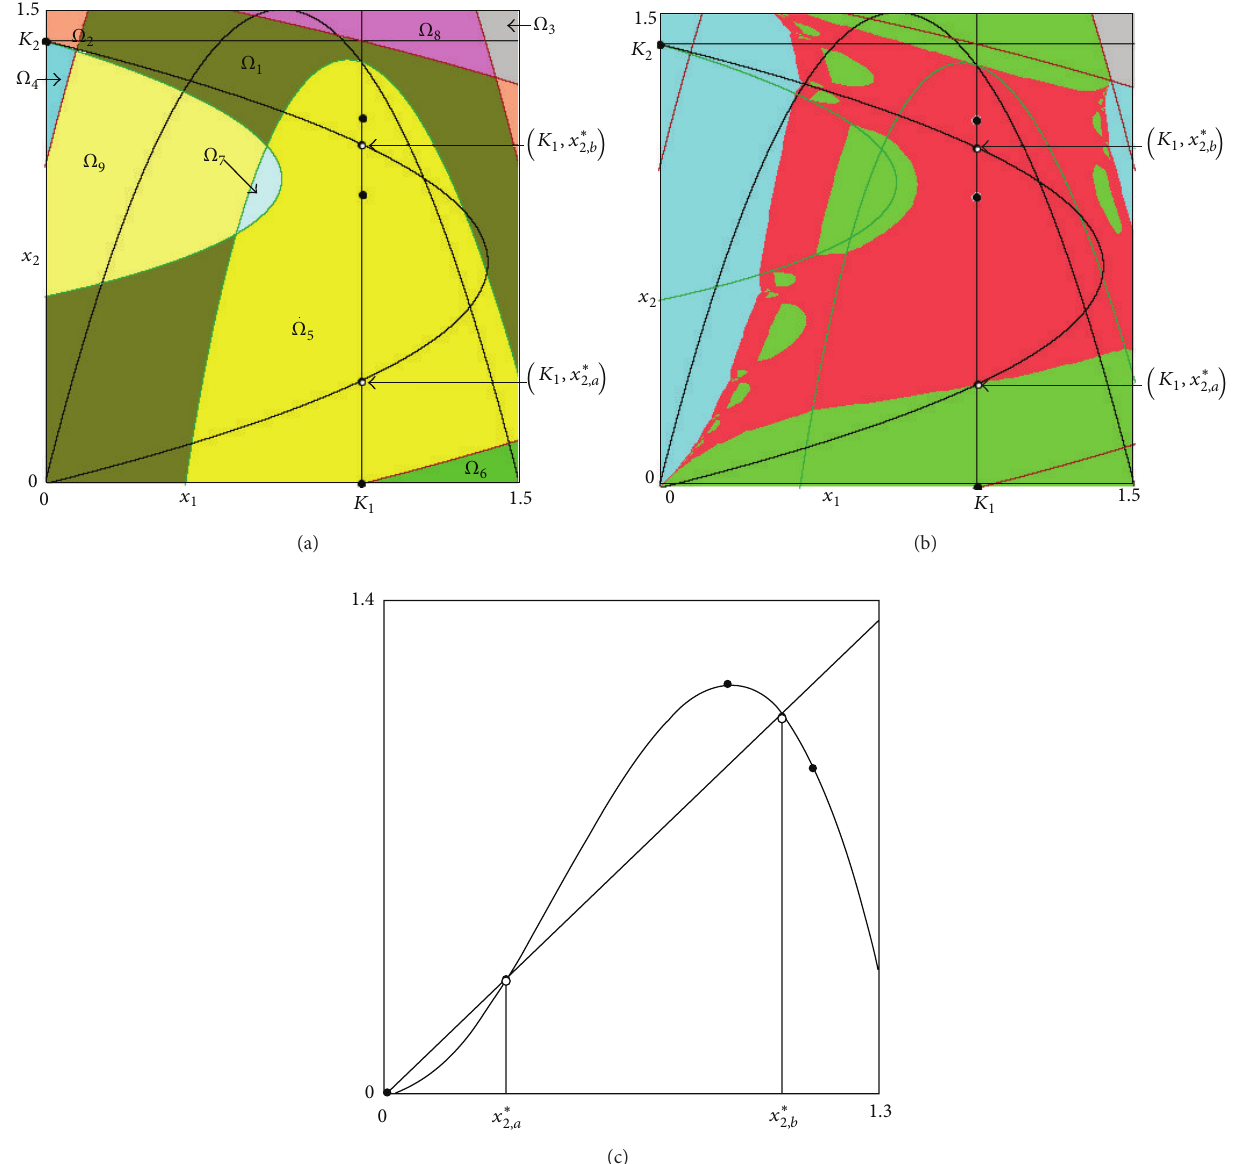
Figure 3: Parameters: 𝑁 1 = 1.5 , 𝑁 2 = 1.4 , 𝜏 1 = 𝜏 2 = 4 , 𝛾 1 = 𝛾 2 = 1 , 𝐾 1 = 1 , and 𝐾 2 = 1.4 . Panel (a), phase space divided in regions Ω 𝑖 , 𝑖 = 1,...,9 . Panel (b), the green (resp., azure) region is the basin of attraction of the superstable equilibrium of segregation (𝐾 ) ), while the red region is the basin of attraction of the stable 2-cycle. In the first two Panels, 𝐵𝐶 (0,𝐾 2 curves and 𝐵𝐶 1,0 and 𝐵𝐶 2,0 the dark-red curves, while 𝜙 1 and 𝜙 2 are the black curves. Panel (c), restriction of the map 𝑇 on 𝑥 1 = 𝐾 1 for ∈ [0, 𝑥 ] 𝑥 2 2,𝑚